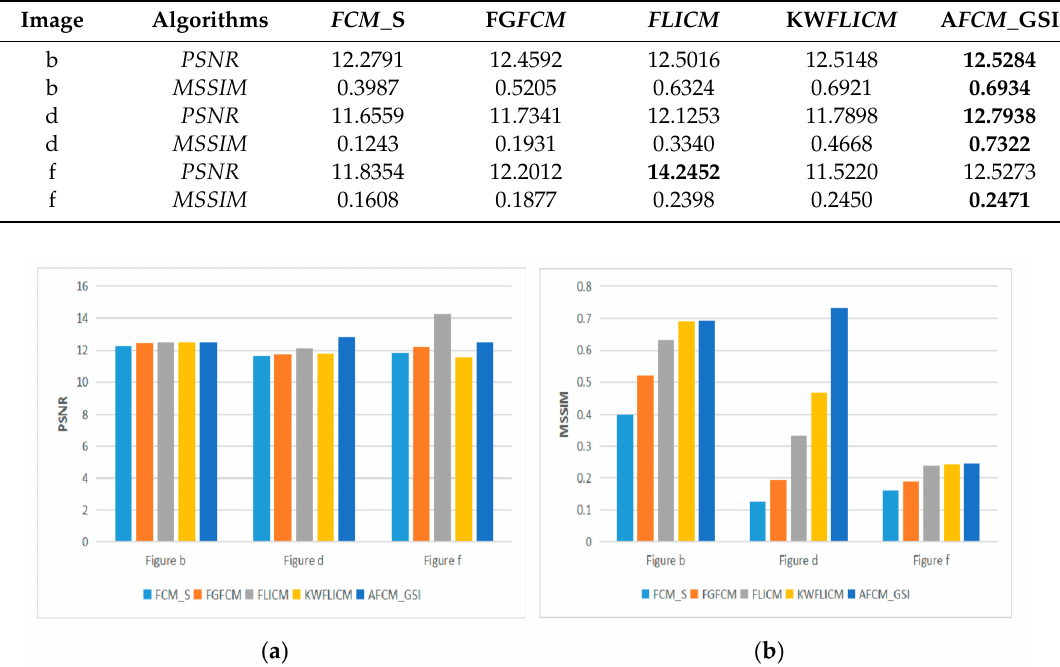
Figure 6. ( a ) segmented image by FCM _S; ( b ) segmented image by FG FCM ; ( c ) segmented image by FLICM ; ( d ) segmented image by KW FLICM ; ( e ) segmented image by A FCM _GSI. Table 2. Peak signal to noise ratio ( PSNR ) and mean structural similarity ( MSSIM ) of five algorithms on noisy natural images and remote sensing image 1.